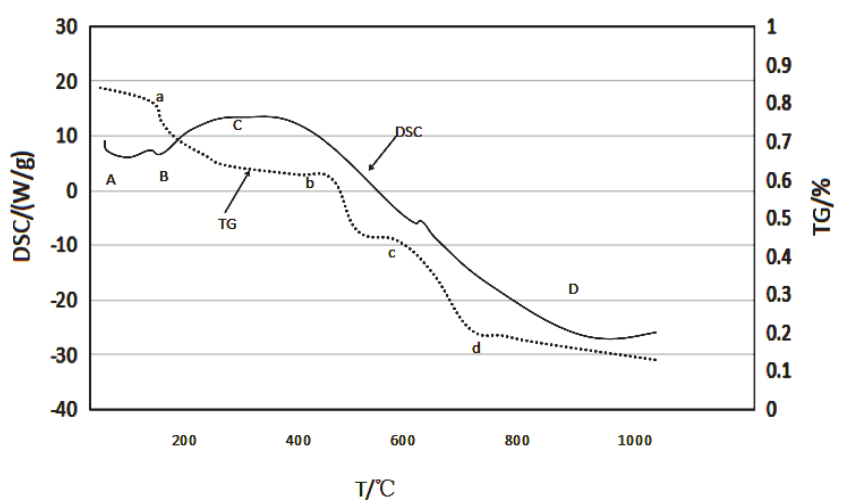
Figure 10: DSC-TG curve of